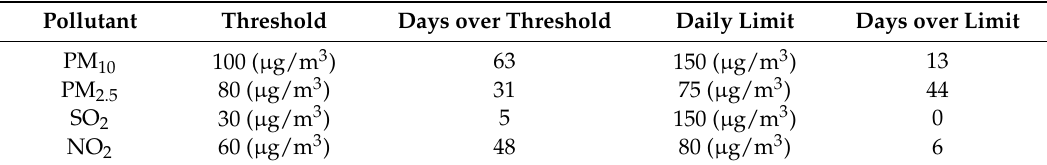
Table 7. Threshold concentration in Shenzhen and daily limit concentration in air quality standard in China. Pollutant Threshold Days over Threshold Daily Limit Days over Limit PM 10 100 ( µ g/m 3 ) 63 150 ( µ g/m 3 ) PM